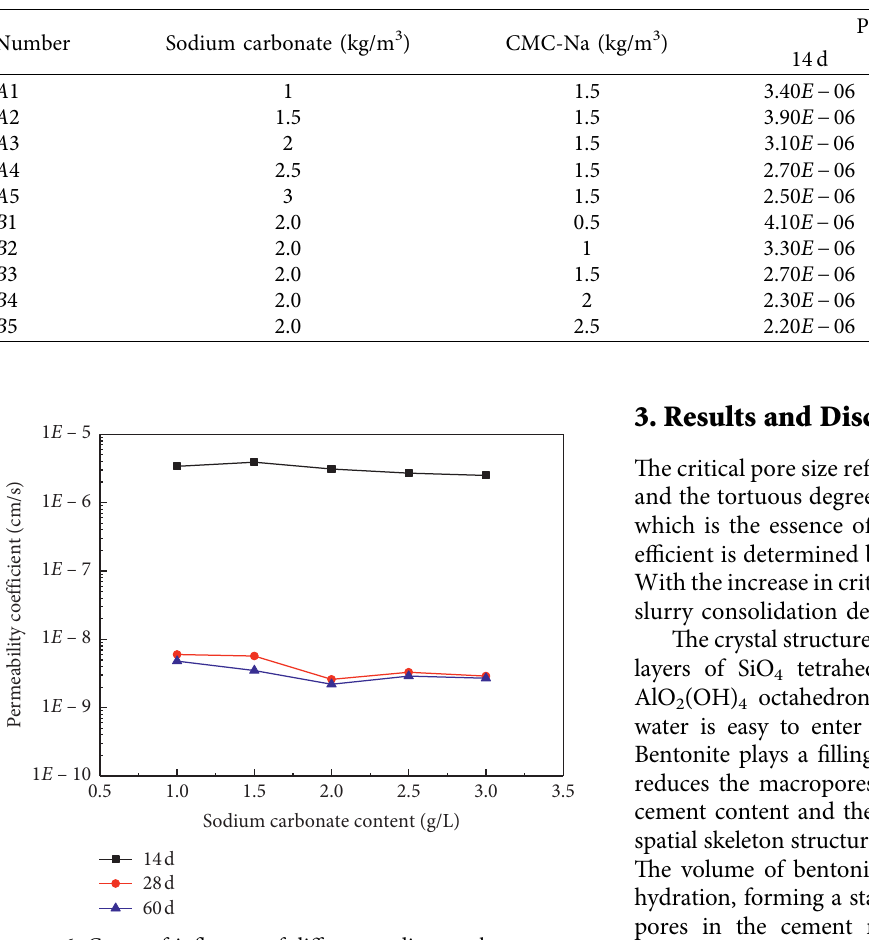
Figure 6: Curve of influence of different sodium carbonate con- tents on permeability coefficient of samples.